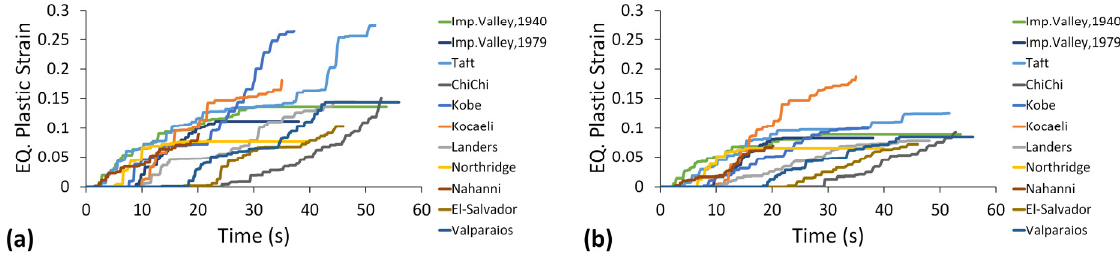
Figure 17. Max. equivalent plastic strain in configuration 30 under selected earthquake: ( a ) in beam and ( b ) in column.